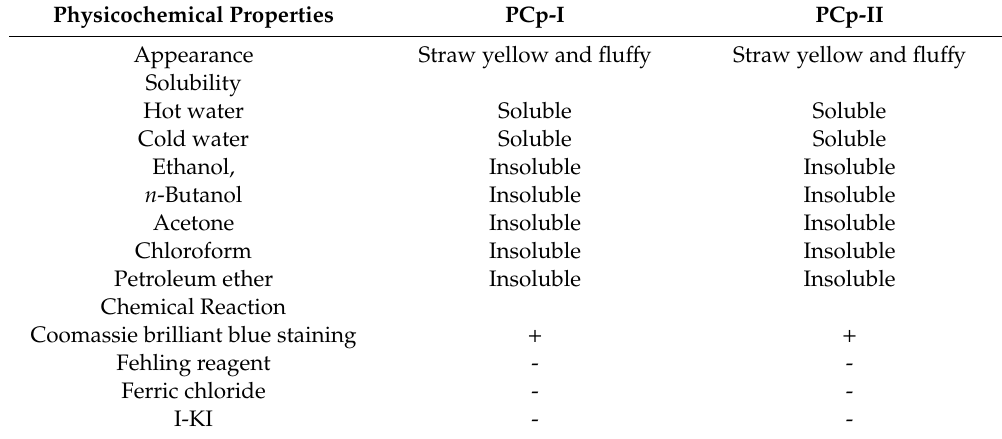
Table 1. The general physicochemical properties of PCp-I and PCp-II.